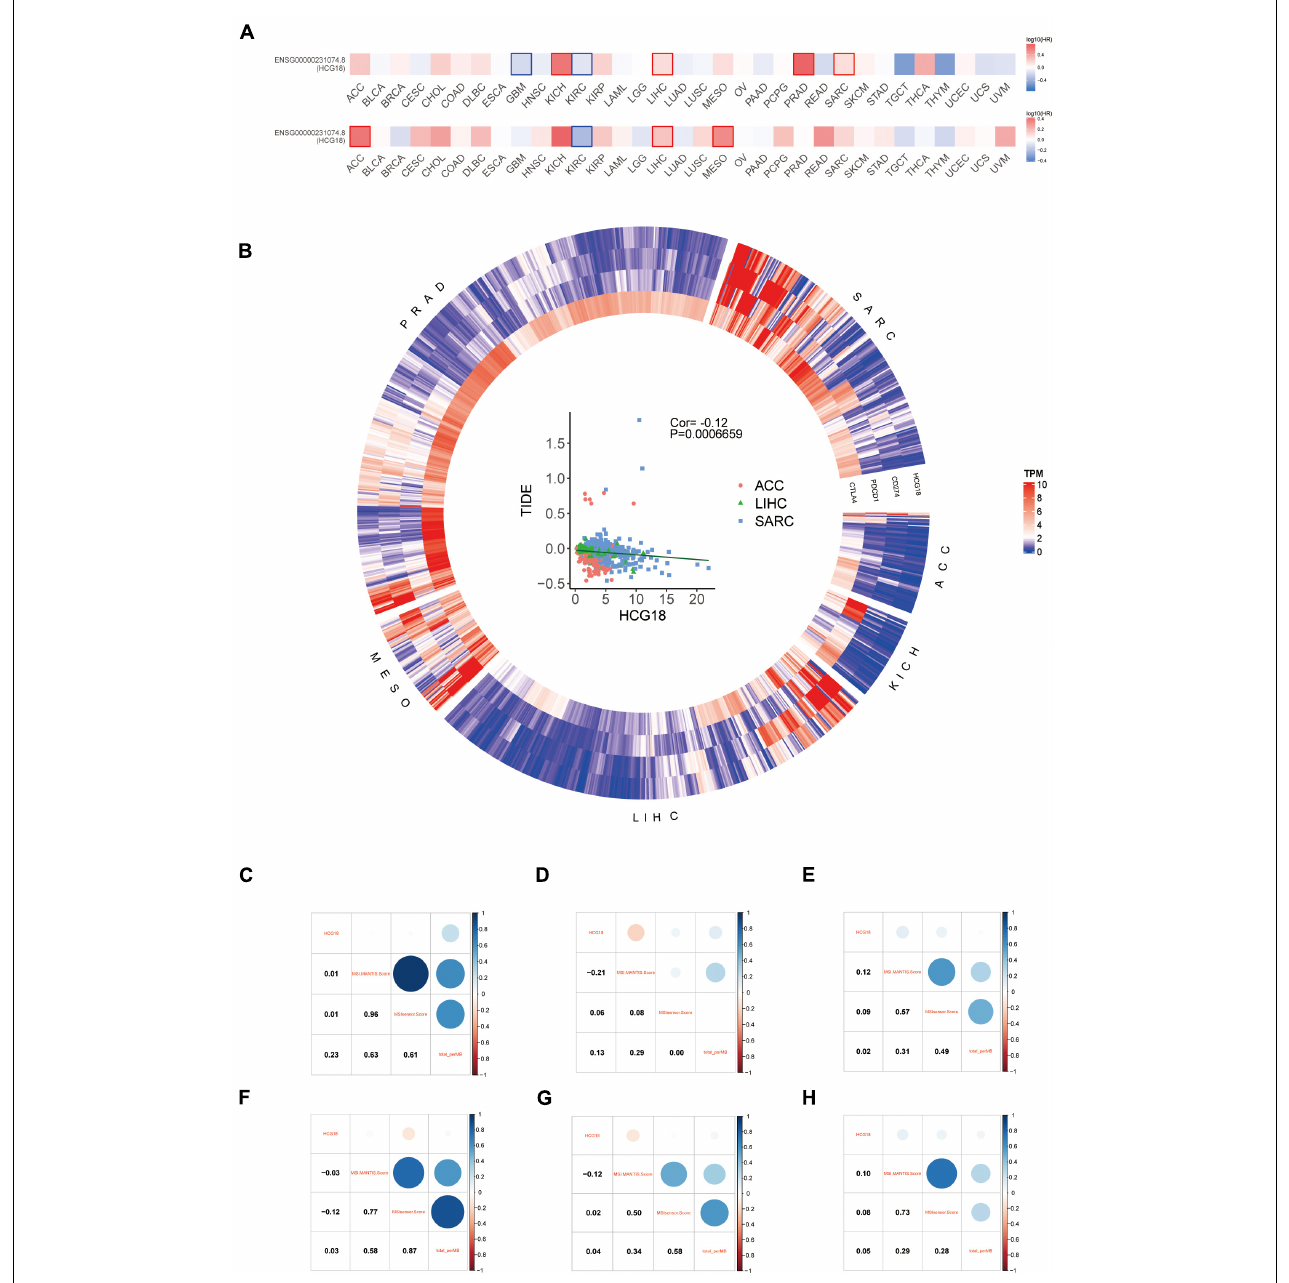
FIGURE 7 | Pan cancer analysis of the effect of HCG18 on immunotherapy. (A) Survival map of overall and progression-free survival of HCG18 based on TCGA. (B) Heat maps of HCG18, CD274, PDCD1, and CTLA4 expression in six HCG18-related cancers ( P value < 0.05). Scatter plot of TIDE score and HCG18 expression in LIHC, ACC, and SARC (COR = –0.12, P value < 0.001). (C–H) The correlation graph of HCG18 expression with MSI score and TMB in ACC, KICH, LIHC, MESO, PRAD, and SARC,